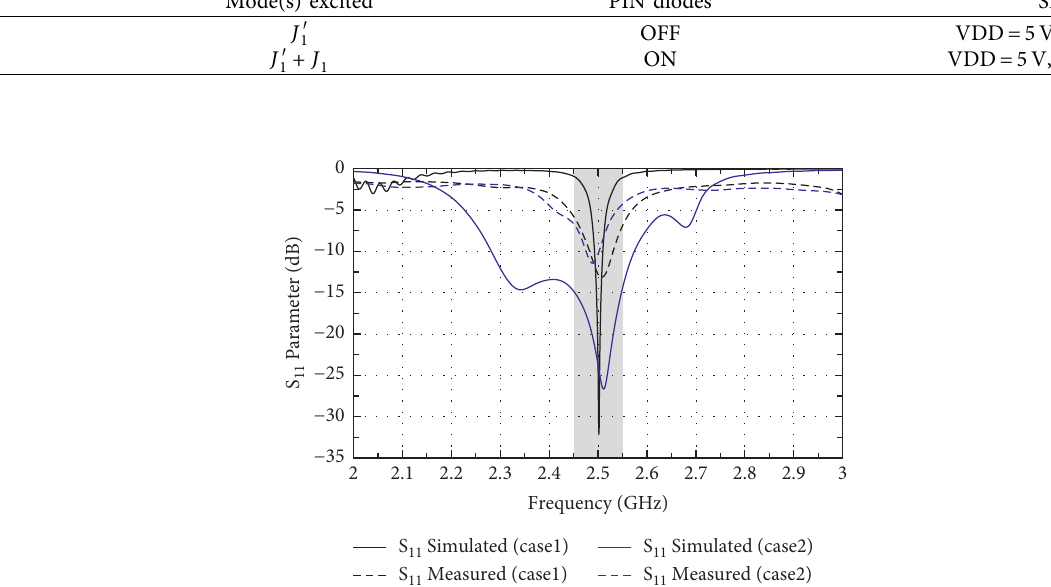
parameter for the ON/OFF cases presented in Table 11